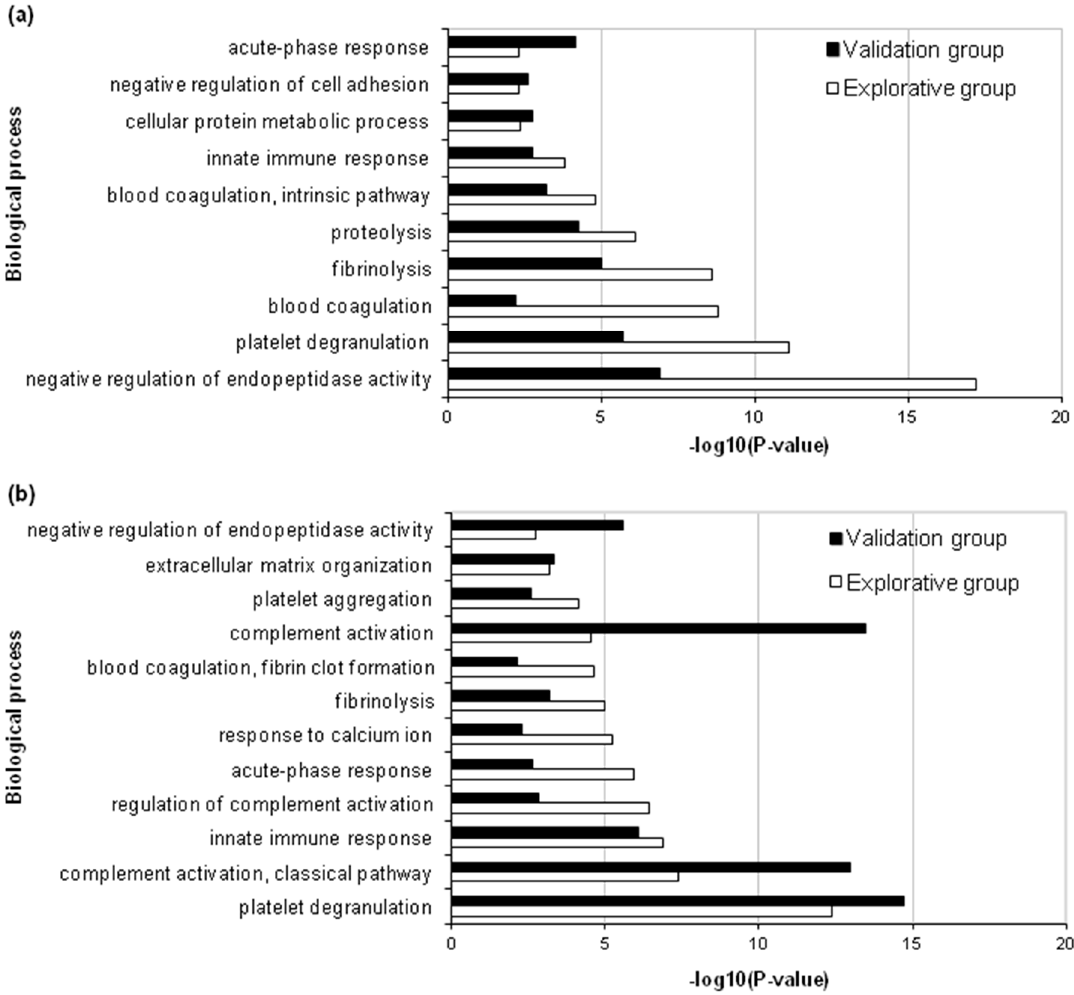
Figure 2. Most significant ( p < 0.01) biological processes associated with differentially abundant plasma proteins according to DAVID Bioinformatics Resources and common to the explorative and validation analyses. ( a ) Non-relapsing HL. ( b ) Relapsing HL.